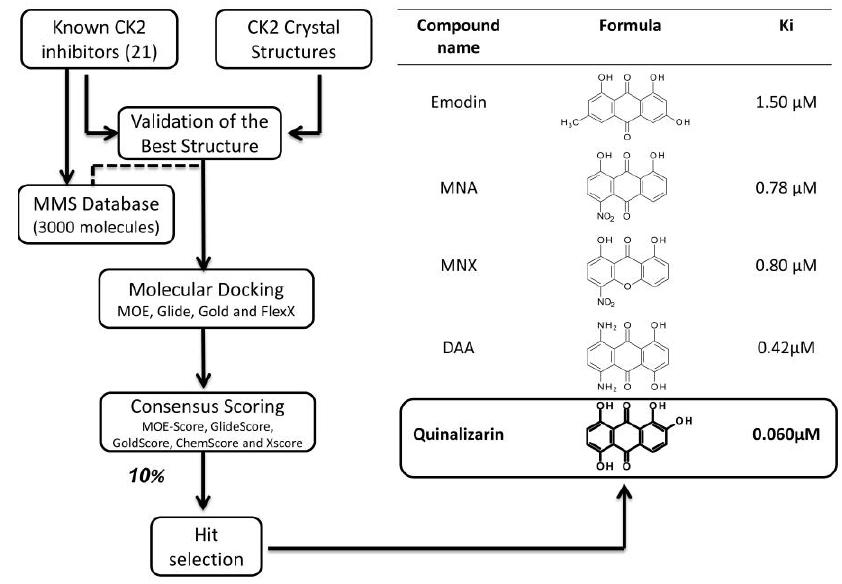
Figure 5. Schematic representation of the structure based virtual screening procedure leading to the discovery of quinalizarin ( left ); whose activity is shown in comparison with the previous discovered anthraquinone inhibitors ( right ).